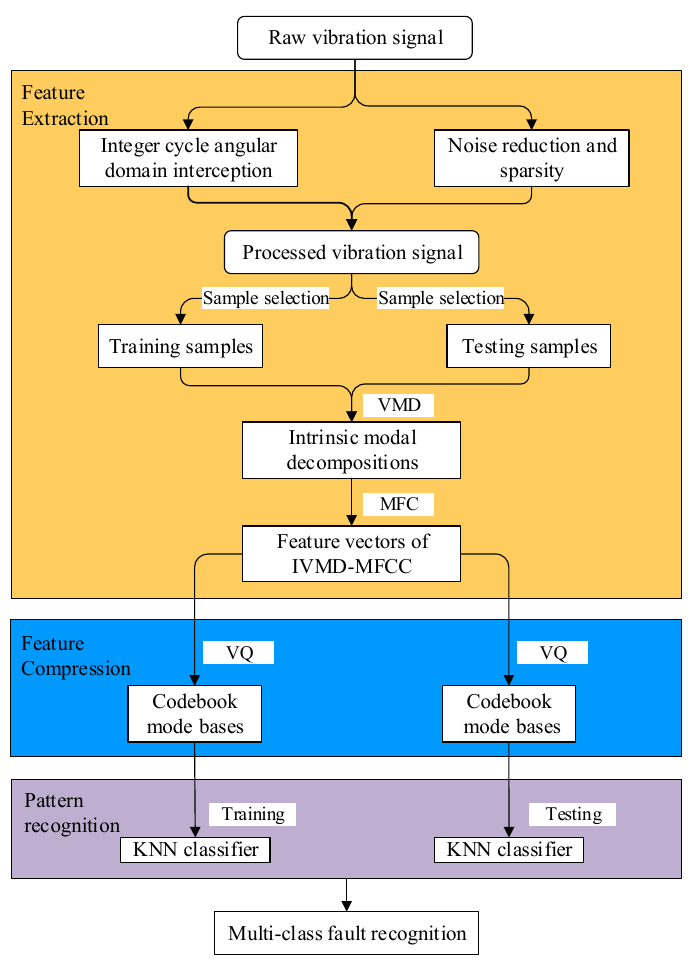
Figure 12. Schematic of the proposed method. KNN, K-nearest neighbor; VQ, Vector quantization.